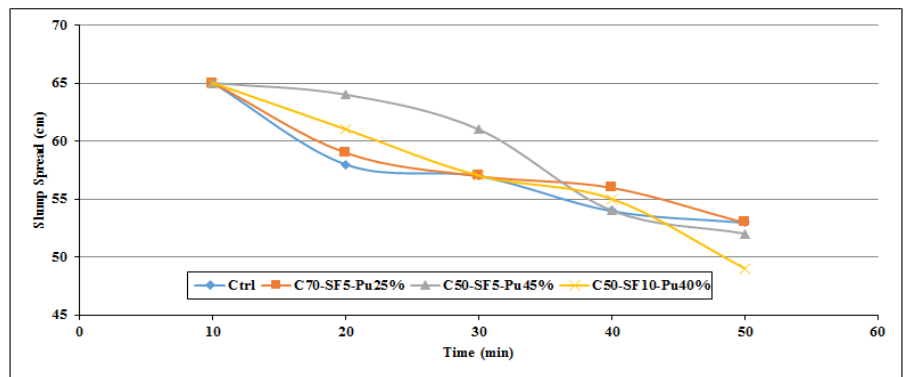
Figure 10. Slump loss diagram for ternary blends in the first 50 min. Figure 11 indicates the SP demand chart for ternary mixes based on the fixed slump of 65 cm, which reveals that the C50-SF5-Pu45% model has the most demand of SP dosage among other samples.